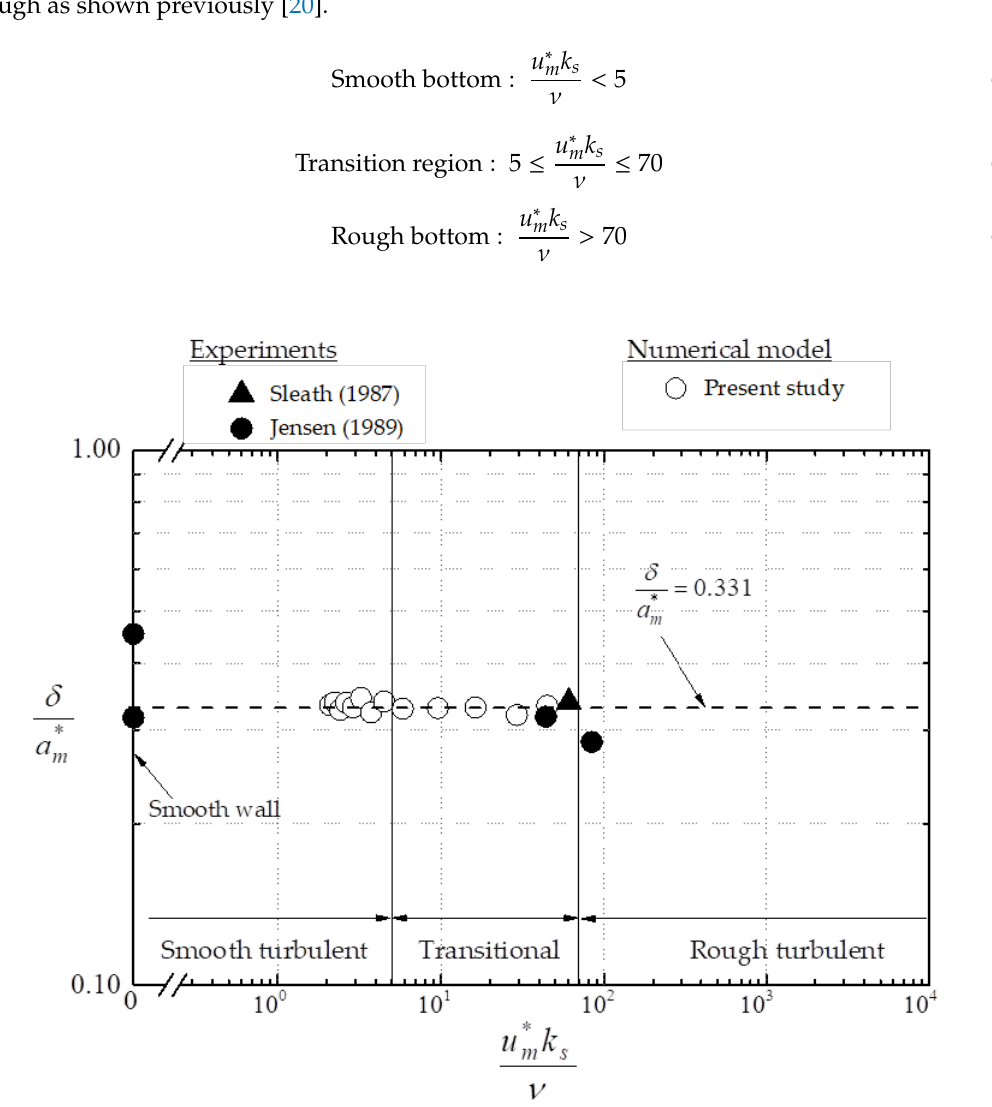
Figure 7. Wave boundary layer thickness in terms of Equation (15).